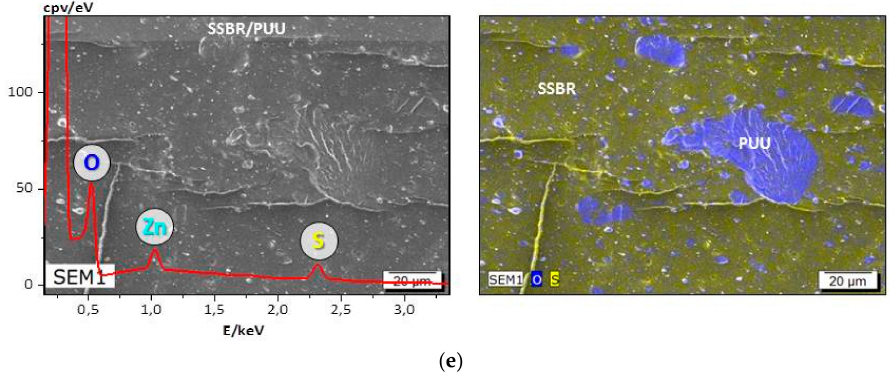
Figure 8. SEM, SEM-EDX images along with the respective EDX spectrum of: ( a ) XNBR/PUU; ( b ) CR/PUU; ( c ) NR/PUU; ( d ) EPDM/PUU; and ( e ) sSBR/PUU blends. Elemental oxygen mapping (O) identifies PUU domains in blends.